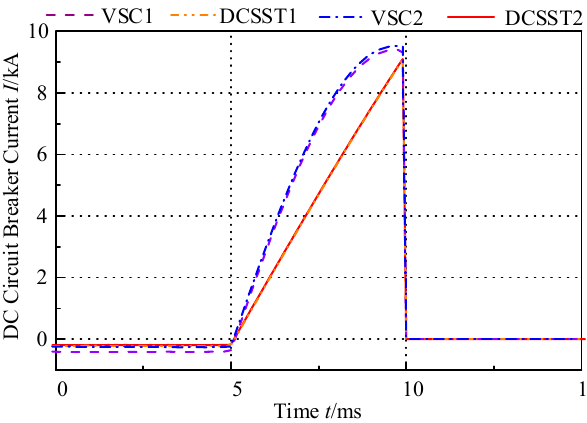
Figure 17. The current of the DC circuit breakers in each device under F1 fault.